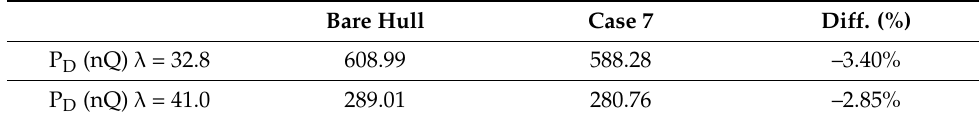
Table 15. Comparison of CFD results for scale